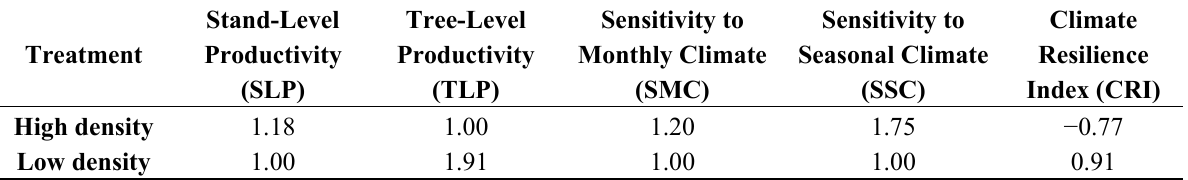
Table 4. Climate Resilience Index (CRI) derived from a combination of relative indexes of productivity (Stand-Level Productivity (SLP), Tree-Level Productivity (TLP)) and sensitivity to climatic stress (Sensitivity to Monthly Climate (SMC) and Sensitivity to Seasonal Climate (SSC)) of red pine in Michigan managed under two initial density treatments. SLP, TLP, SMC, and SSC are relative index variables which were calculated by dividing raw values for each treatment type by thinning treatment with the smallest value. A relative index greater than 1 indicates greater relative value for that variable. CRI = SLP + TLP − SMC −